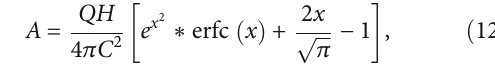
Figure 1: Stress analysis of the hydraulic fl ushing